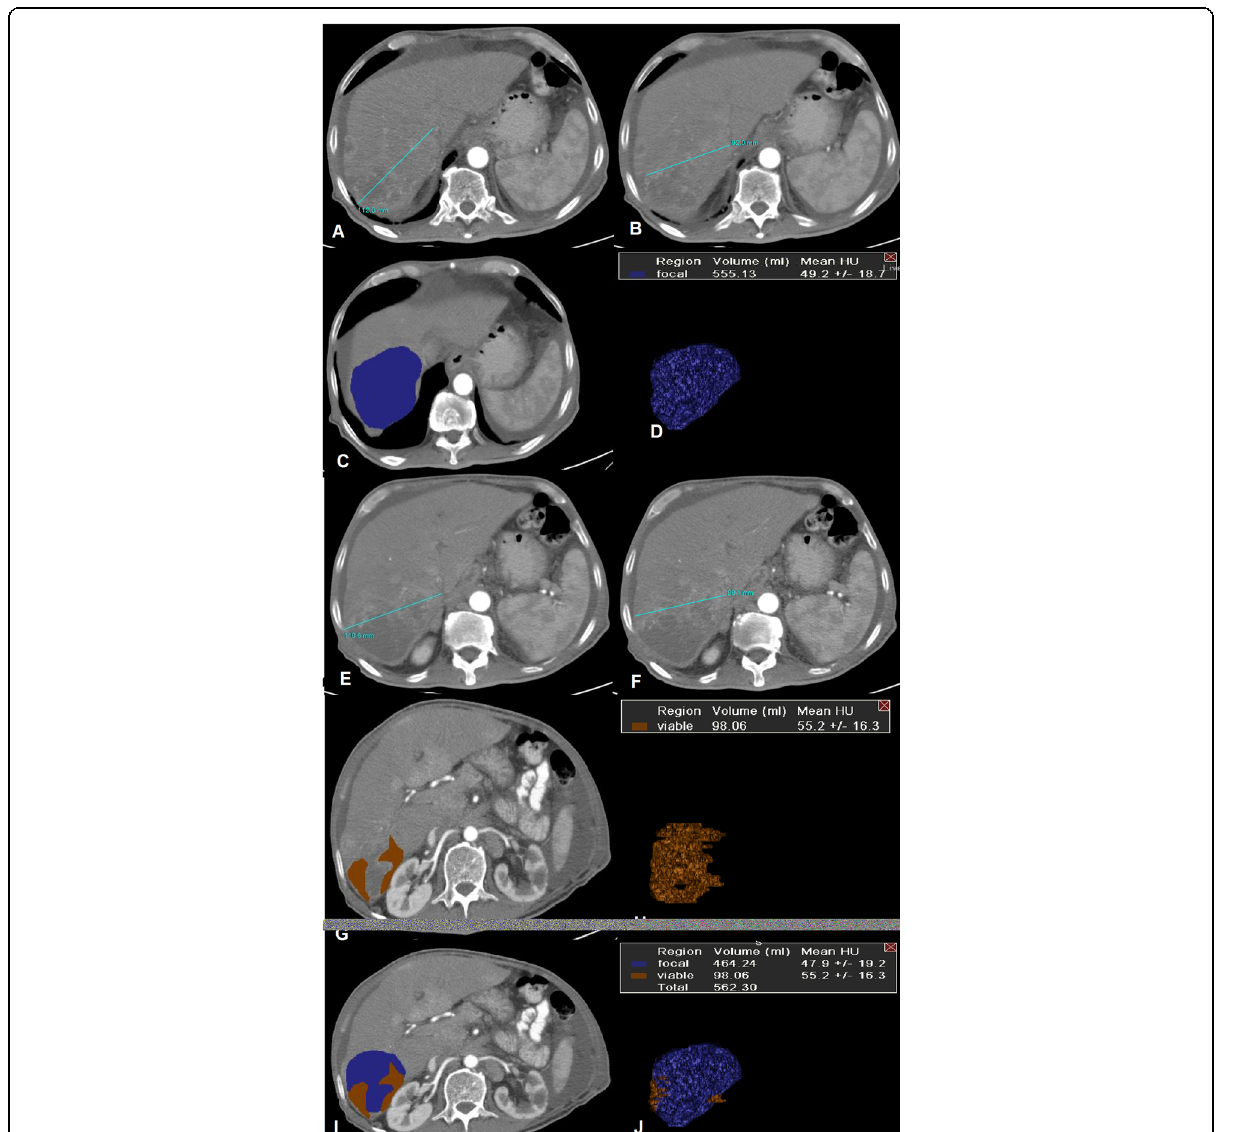
Fig. 4 A 67-year-old male with hepatitis C cirrhosis complicated by development of right lobe HCC. Child Pugh Score: B, BCLB: B. A Pre-TACE axial arterial phase image showing measurement of the lesion according to RECIST, B pre-TACE axial arterial phase image showing measurement of the lesion according to mRECIST and C pre-TACE axial arterial phase image showing measurement of the lesion according to vRECIST, D vRECIST 3D image showing the lesion ’ s volume, E post-TACE images showing lesion ’ s measurement according to RECIST, F measurement according to mRECIST by measuring the diameter of the enhancing component only, G volumetric assessment of the viable component only, H 3D image showing the volume of the viable component, I vRECIST of the whole lesion post-TACE, J 3D image of the whole lesion ’ s volume. According to mRECIST, the lesion shows stable disease (nonresponder) (< 30% decrease in the diameter of viable component) while according to vRECIST, the lesion shows partial response (responder) (> 65% decrease in the diameter of viable enhancing